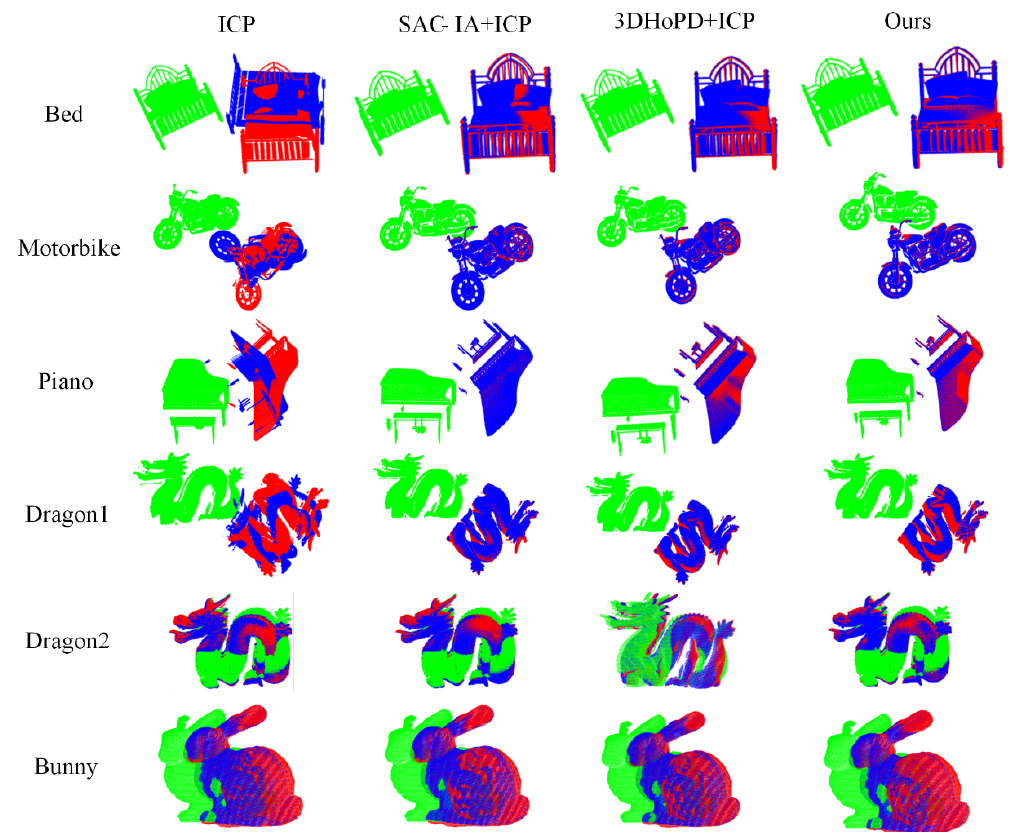
Figure 12. Registration results of each algorithm.